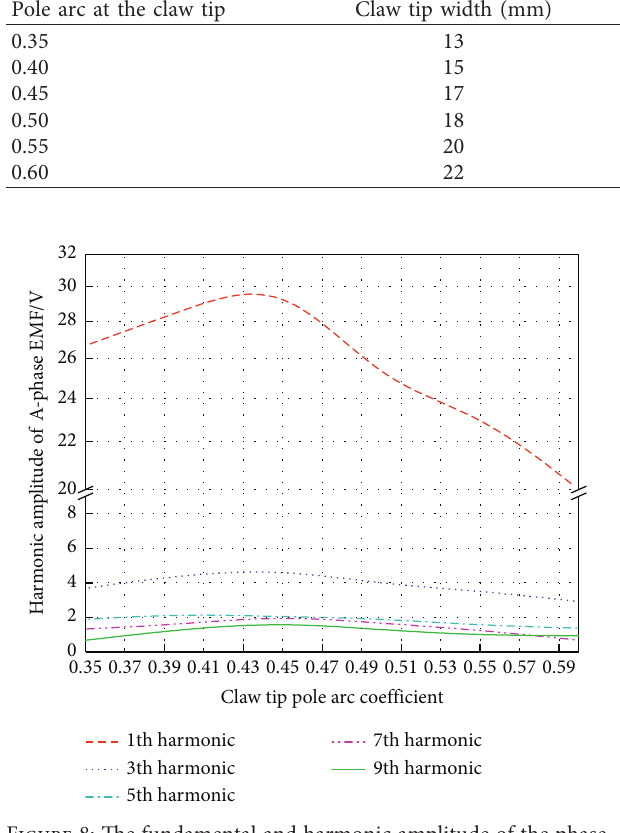
Figure 8: The fundamental and harmonic amplitude of the phase EMF.